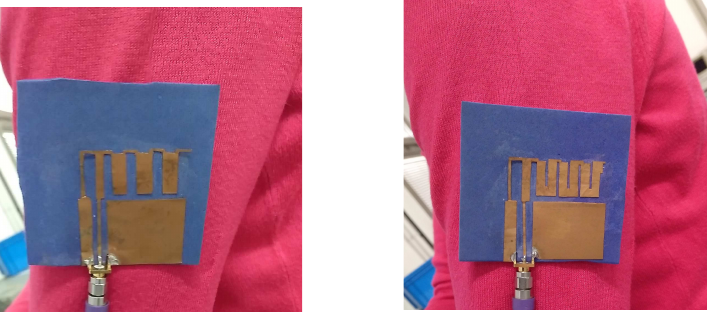
Figure 10. Measurement of the final prototypes on the body. ( Left ) the one obtained with the CRO-4SL; ( Right ) the one obtained with the